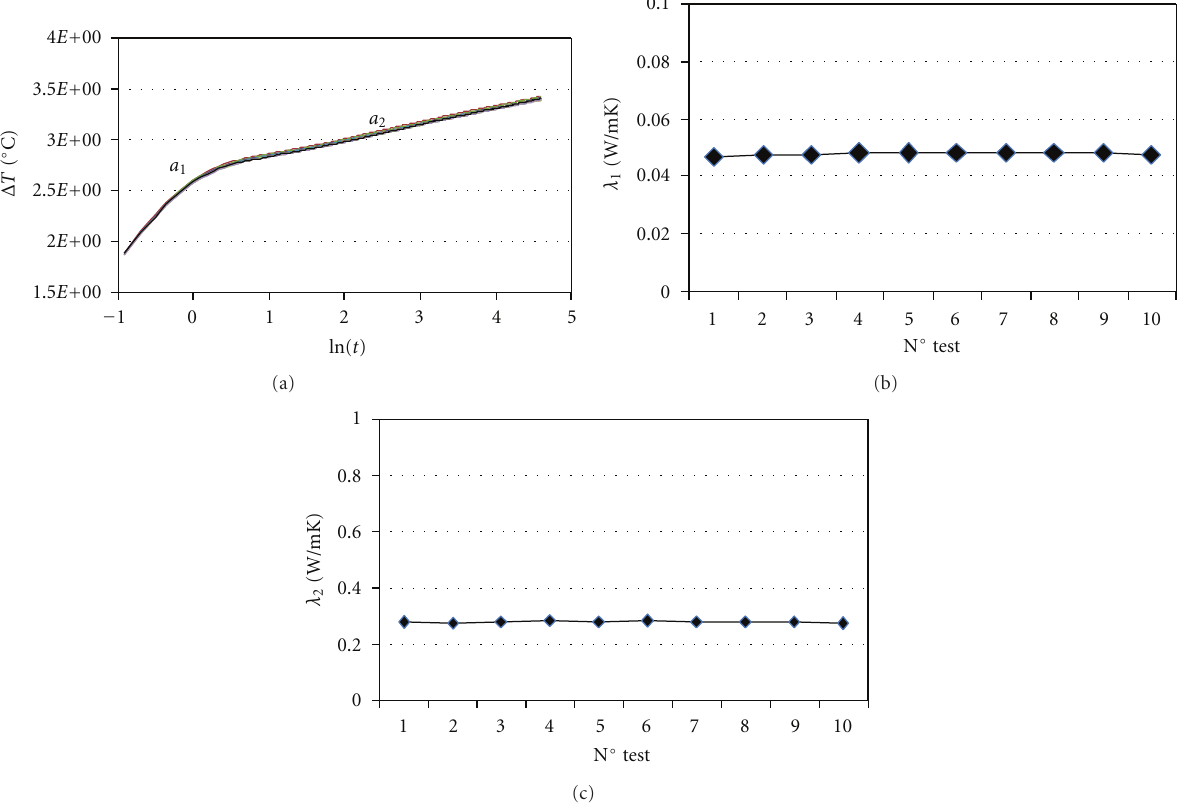
Figure 3: (a) Superimposition of the Δ T/ ln( t ) curves for 10 successive measurements on 2mm diameter glass beads, (b, c) evolution of the measured λ 1 and λ 2 : λ 1 = 0 . 048 W/mK with 0.001 W/mK standard deviation, λ 2 = 0 . 277 W/mK with 0.004 W/mK standard deviation.